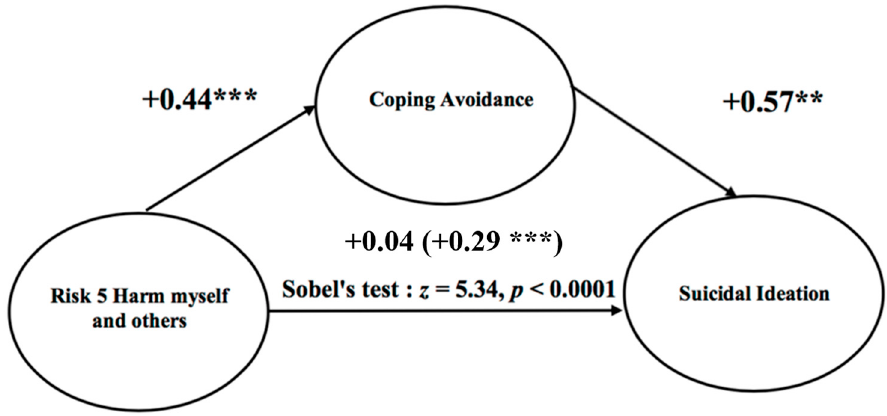
Figure 1. The effect of Risk 5 Harm myself and others for Suicidal Ideation after controlling for Coping Avoidance. The number in parentheses indicates the direct effect of Risk 5 on Suicidal Ideation prior to controlling for Coping Avoidance. ** p < 0.001. *** p < 0.001.